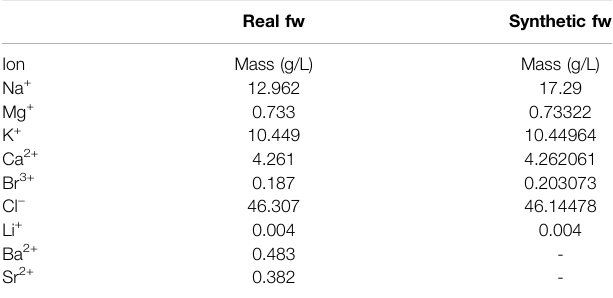
TABLE 2 | Ionic composition of real and synthetic Sognefjord formation water (fw) used for the laboratory and PHREEQC models. Salts (NaCl: 43.95 g; MgCl 2 · 6H 2 O: 6.13 g; KCl: 19.92 g CaCl 2 · 2H 2 O: 15.63 g; BrCl3: 0.44 g, LiCl: 0.03 g) were mixed with deionized water to make up a total of 1 L solution. Ba2+ andSr − werenotusedinthelaboratoryforsafetyreasons.Thecompositionof the “ real ” Sognefjord formation water (fw) is from Kinn et al. (1998). The conductivity of the synthetic formation water is 111.3 mS/cm and a resistivity of 898.47 Ohm